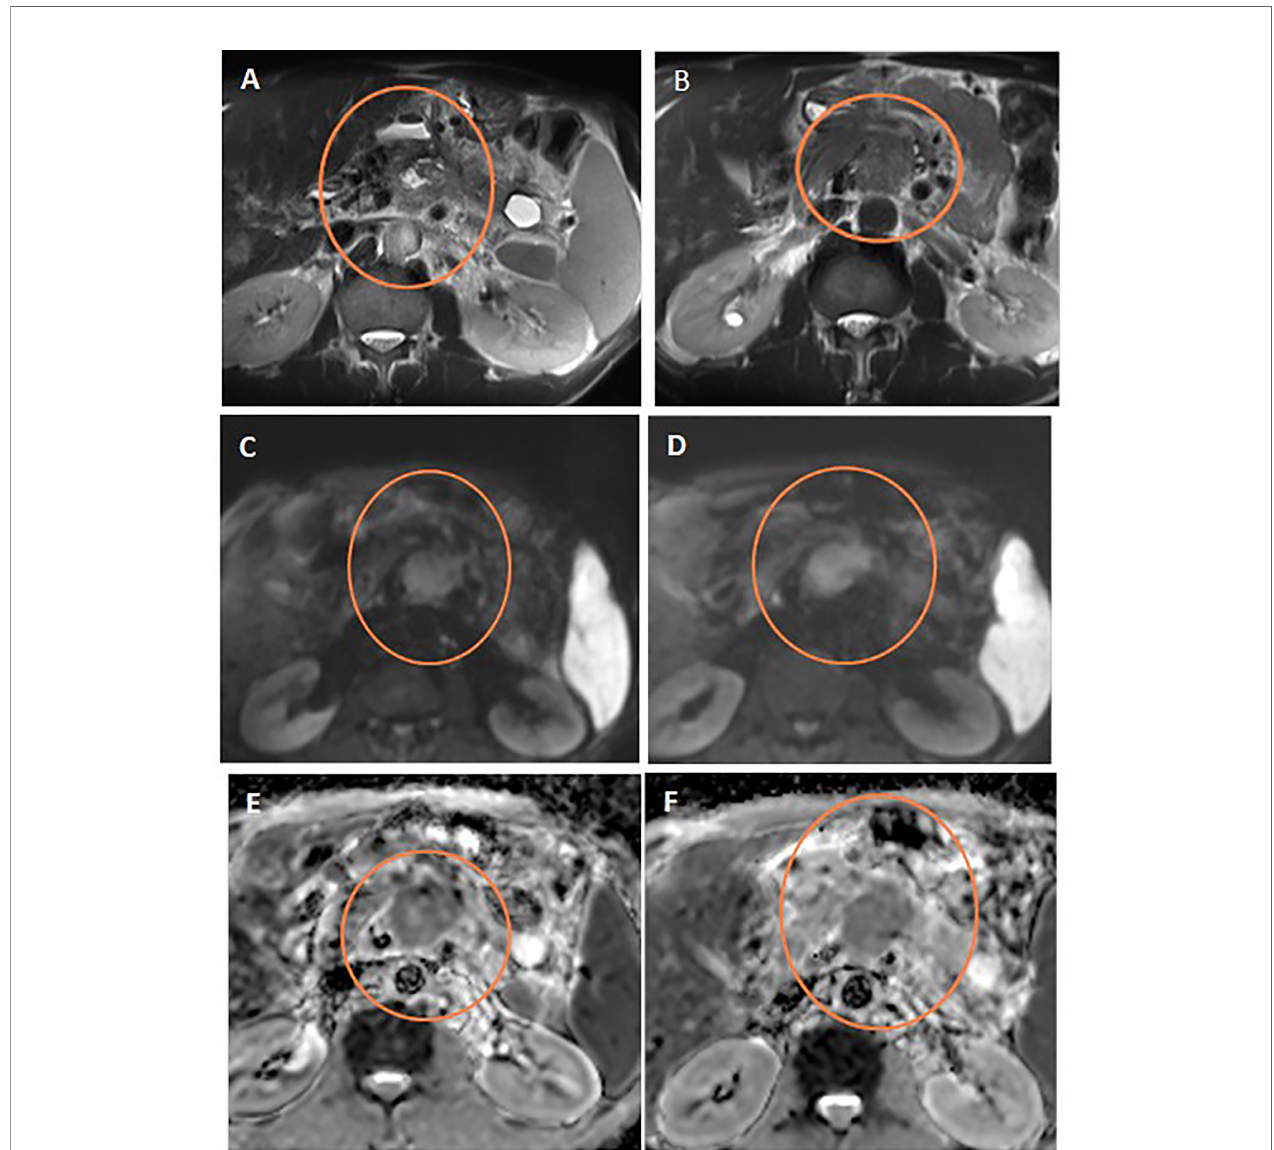
FIGURE 5 | Discordant response between ADC and RECIST. Axial T2WI (A) shows stationary size of the pancreatic mass after neoadjuvant therapy compared to initial axial T2WI (B) . Note the central cystic change of the mass of necrosis. Post-treatment and initial DWIs ( C, D , respectively) show corresponding restricted DWI of the mass. Post-treatment and initial ADC maps ( E, F , respectively) show regression of the ADC values of the mass on post-treatment study compared to initial one.